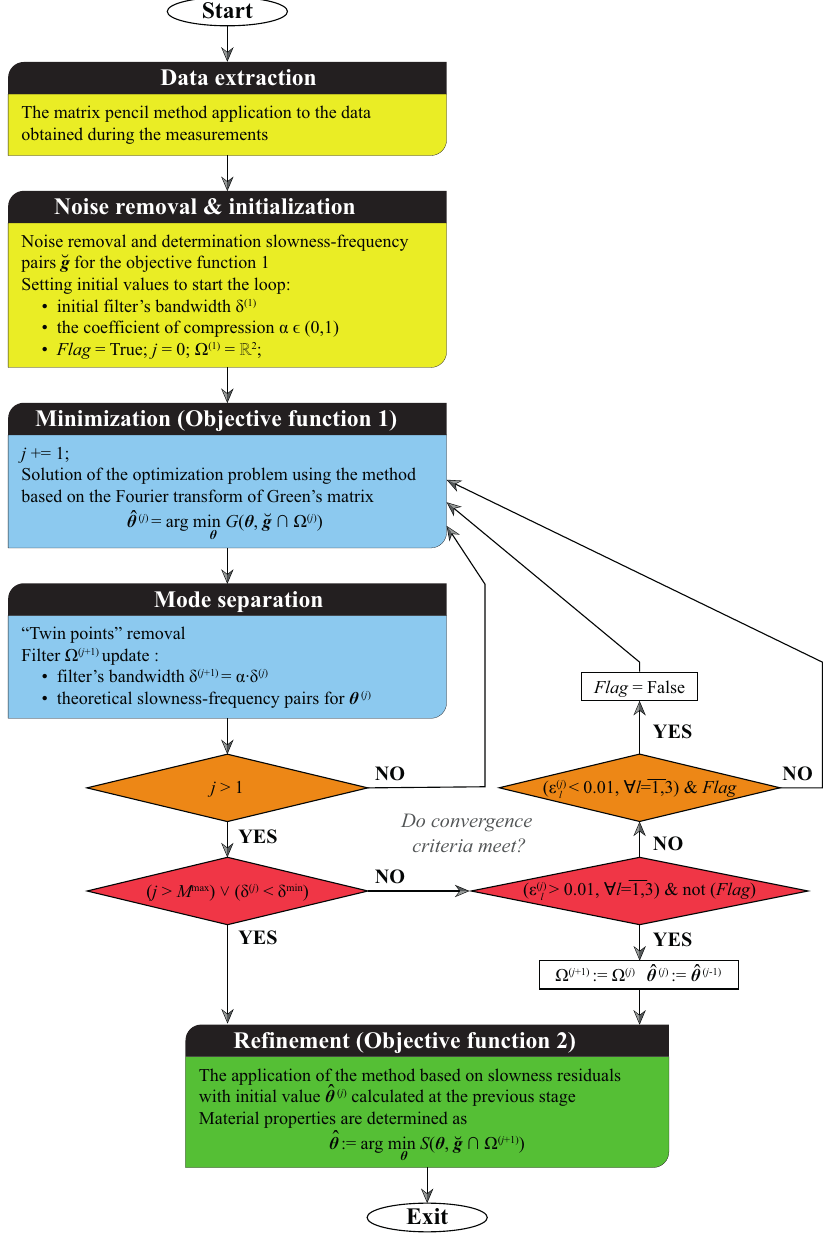
Figure 3. Flowchart of the proposed multi-stage